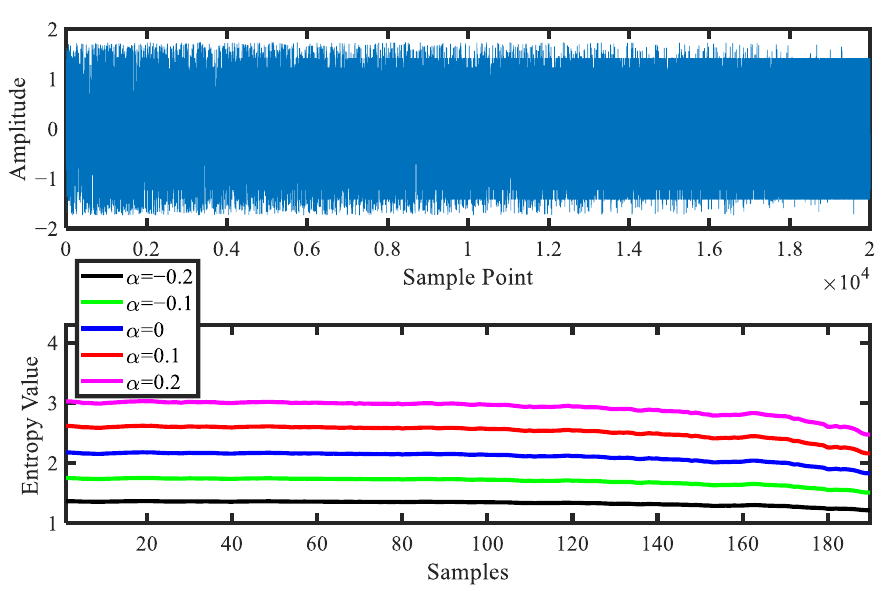
Figure 7. MIX signal ( top ) and the corresponding different entropy curves ( bottom ).